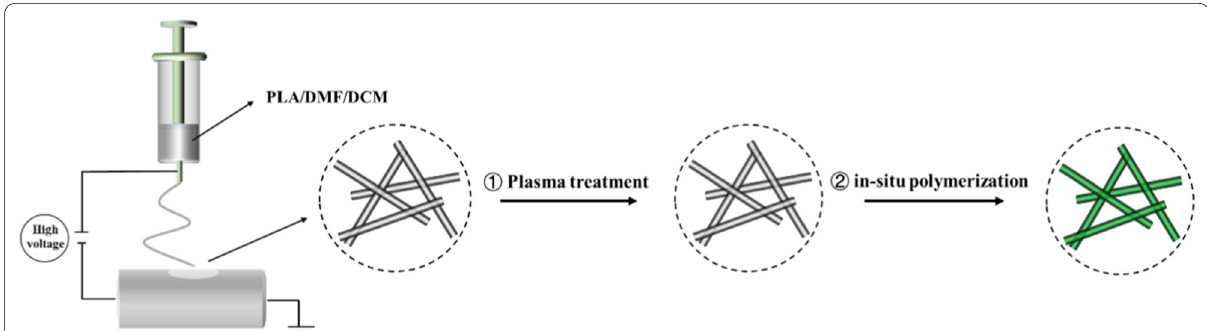
Fig. 1 Schematic depicting the preparation process of PLA and PANI/PLA composite